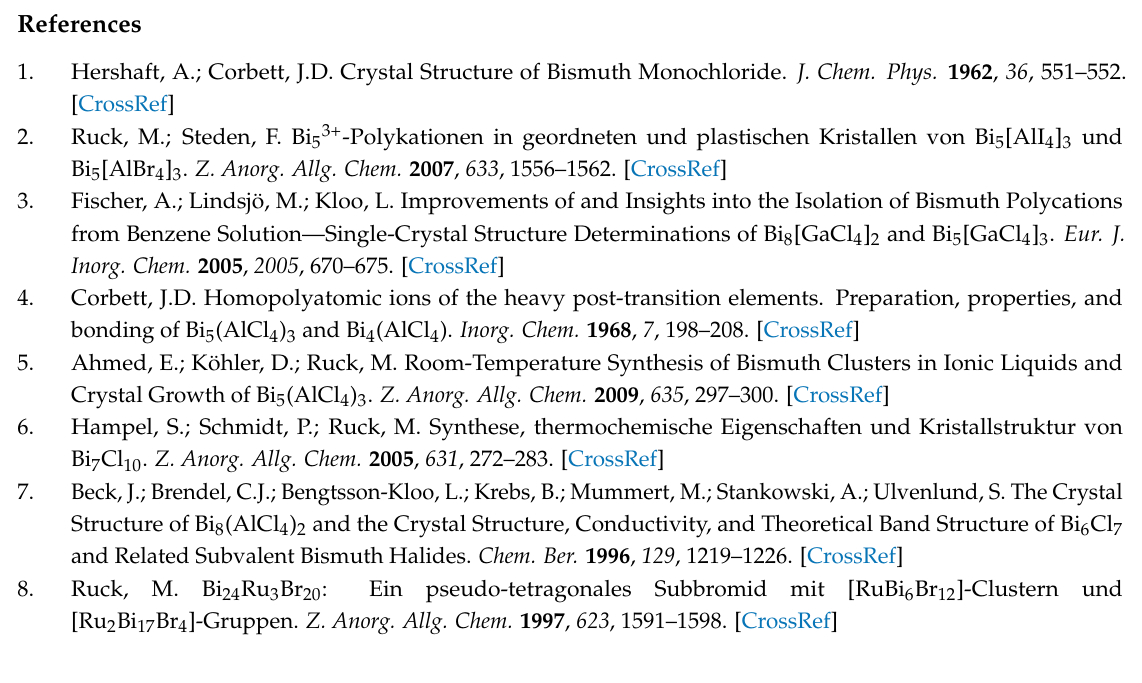
Figure S1: Representation of structural motifs in BaNiO 3 and Bi 8 Tl[AlCl 4 ] 3 according to the hexagonal perovskite structure type. Figure S2: Low-temperature DSC measurement of a sample of (Bi 8 )Tl[AlCl 4 ] 3 . Figure S3: Powder diffractogram of a sample of Bi 8 Tl[AlCl 4 ] 3 crystals without further treatment. Figure S4: Powder diffractogram of the product of a Bi 8 Tl[AlCl 4 ] 3 synthesis after treatment with dry DCM. Scheme S1: Simplified Bärnighausen tree for the symmetry descent at low temperatures. Table S1 : Selected interatomic distances in (Bi 8 )Tl[AlCl 4 ] 3 , Table S2: Coordinates and coefficients of the tensors of the anisotropic displacement and equivalent displacement parameters for the atoms in (Bi 8 )Tl[AlCl 4 ] 3 . Table S3: Coordinates and coefficients of the tensors of the anisotropic displacement, and equivalent displacement parameters for the atoms in (Bi 8 )Tl[AlCl 4 ] 3 at 170(2) K. CIF and the checkCIF output